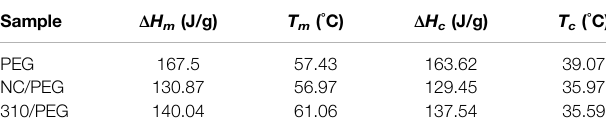
TABLE 1 | Phase change properties of PEG, NC/PEG and 310/PEG.